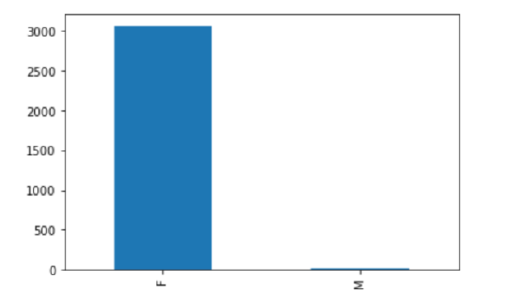
Figure 5. Gender